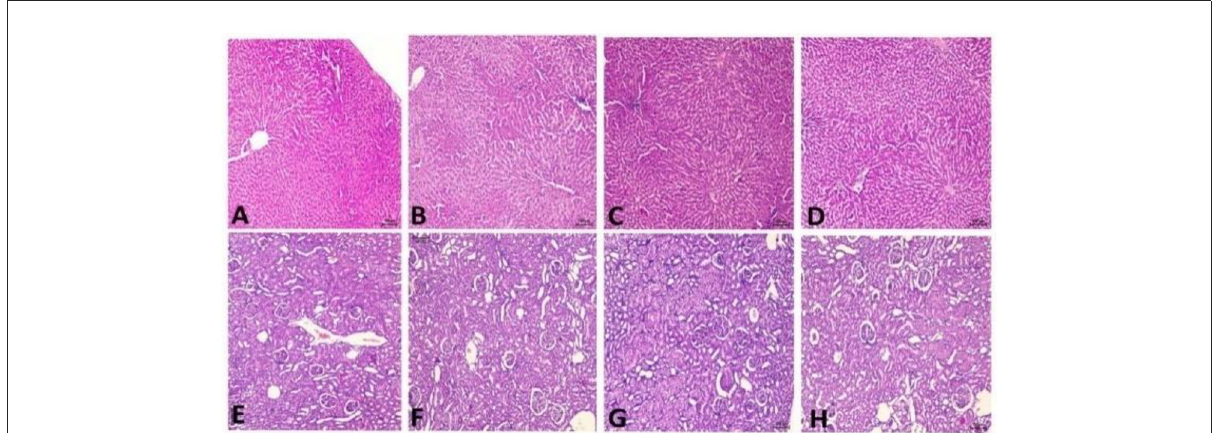
FIGURE10 Histopathology reports. (A) Control group showing moderate lesions in the liver, (B) TD1 group showing mild lesions in the liver, (C) TD2 group showing minimal lesions in the liver, (D) Standard group showing minimal lesions in the liver, (E) Control group showing mild lesions in the kidney, (F) TD1 group showing mild to minimal lesions in the kidney, (G) TD2 groups showing minimal lesion in the kidney, (H) Standard group showed minimal